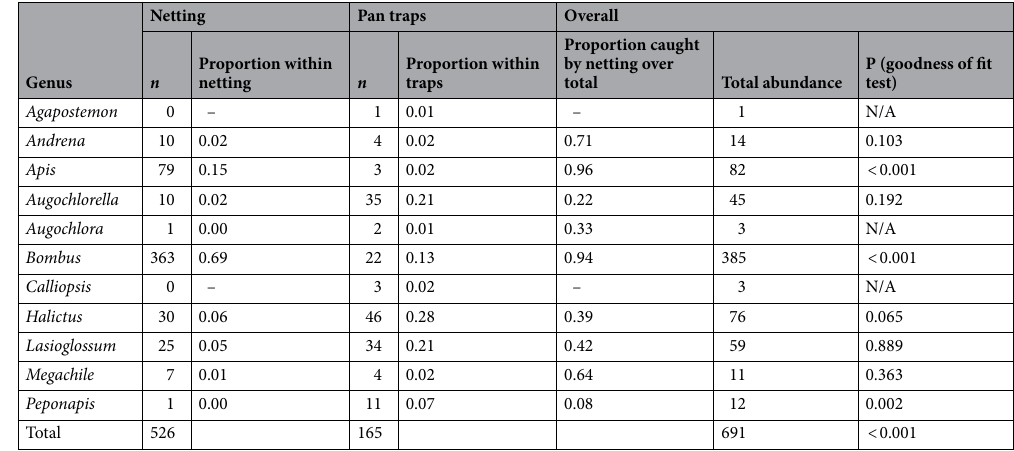
Table 2. Abundance ( n ) and proportion of the different bee genera captured by each survey method. Statistical differences between the two survey methods were determined using the log likelihood ratio test (G-test) with α = 0.05. Although presented in the Table for completeness, the genera Augochlora, Agapostemom and Calliopsis were not included in the statistical test.